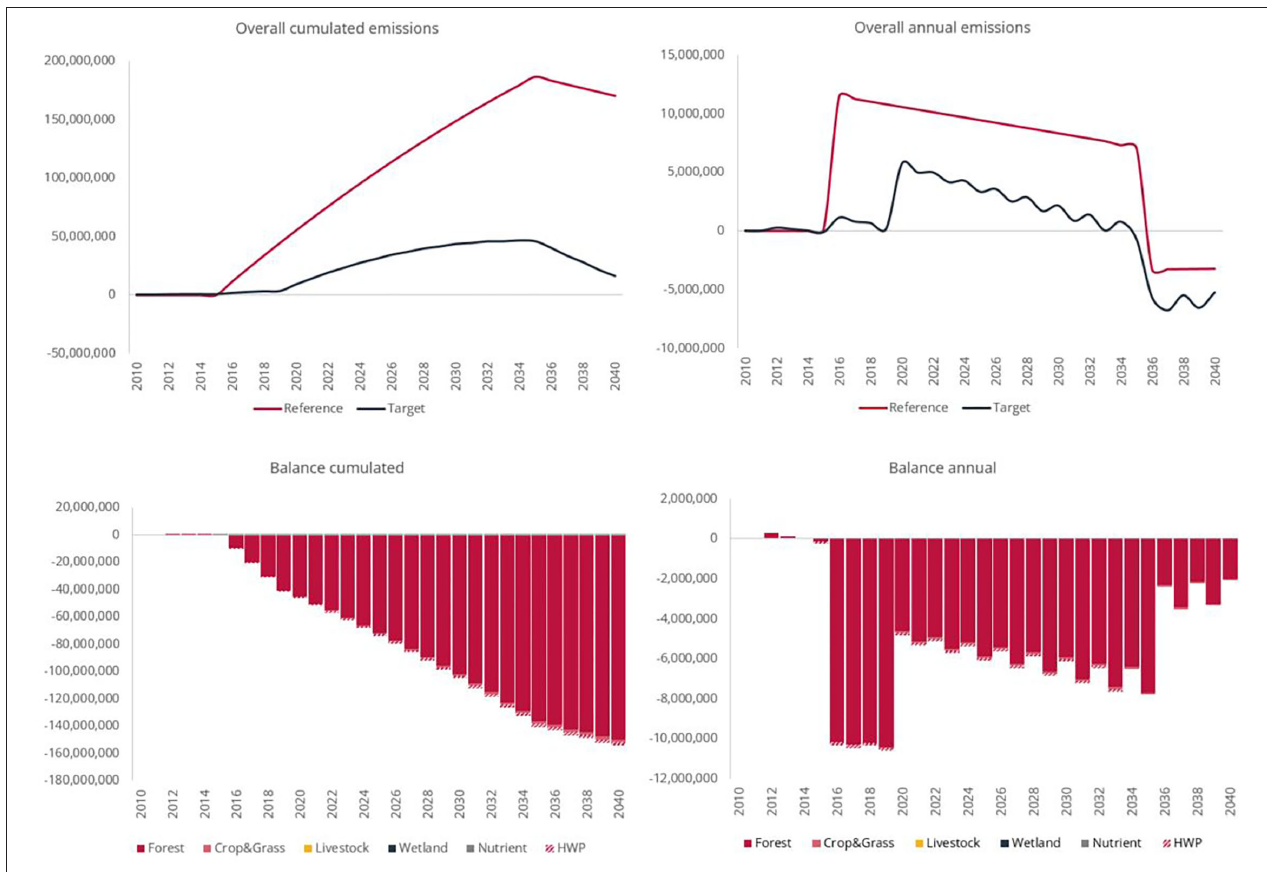
FIGURE 2 | Screenshot of NEXT dashboard on cumulated and annual greenhouse gas fluxes and carbon stock changes for the target, reference scenario, and the balance, in tCO